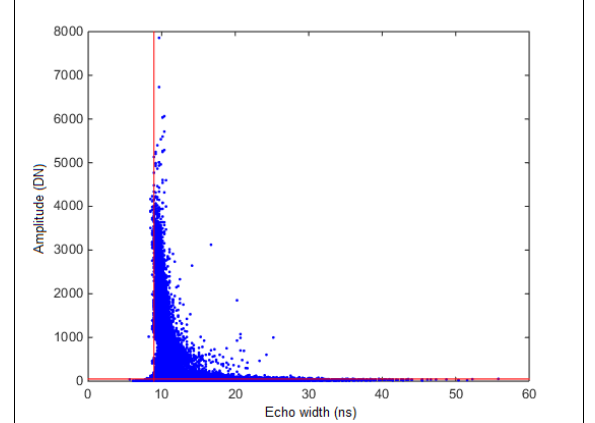
Figure 6. Eisenstadt dataset: Scatterplot of Echo Width versus Amplitude for single echoes. Echoes with more than 1% of the highest Amplitude are placed above the red horizontal line. The vertical line shows the minimum echo width EW min which is 5% quantile of the single echoes above the Amplitude threshold.